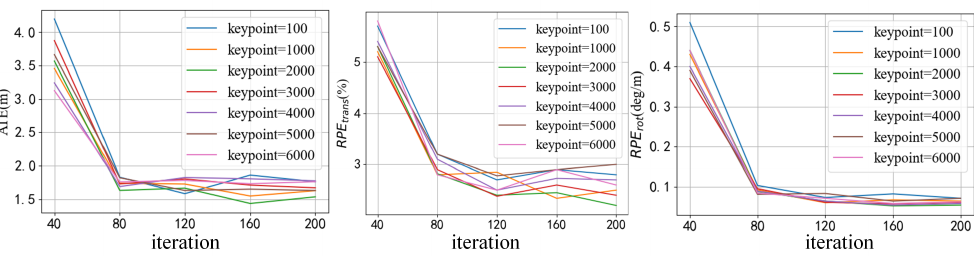
Figure 9. The variation curve of the pose estimation error with the number of training iterations on sequence 09 of KITTI. Each color represents a different number of sampling